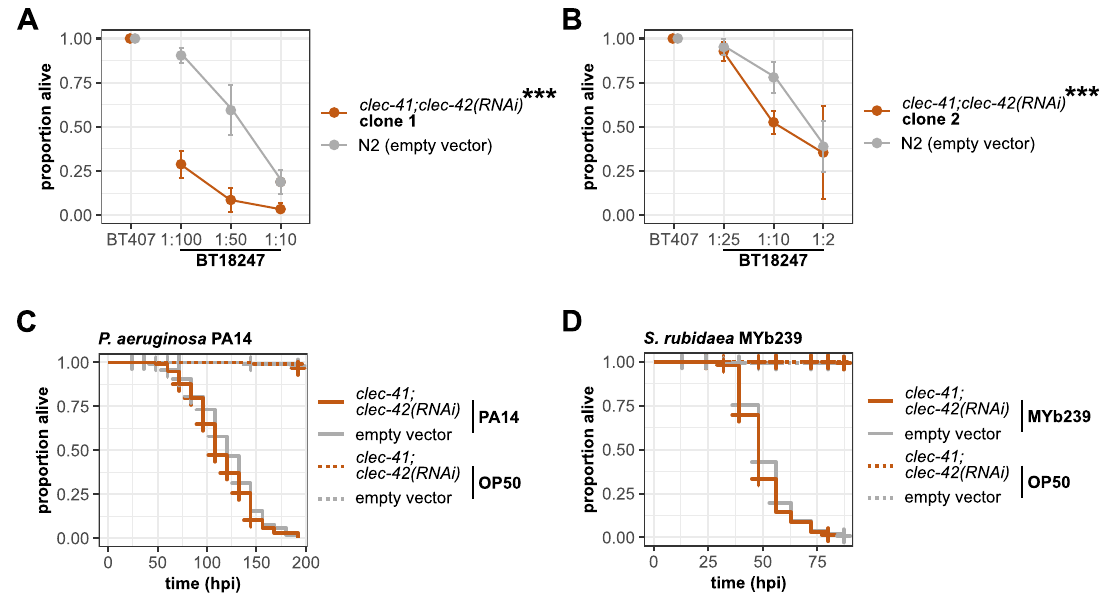
Fig 5. Simultaneous knock-down of clec-41 and clec-42 increases susceptibility to Bt247. (A, B) Difference in survival on serial dilutions of Bt247 and a dilution of 1:10 of the non-pathogenic Bt407 control 24 hpi between clec-41;clec-42(RNAi) worms and empty vector control worms using either (A) RNAi clone 1 (Ahringer library V-8P17) or (B) RNAi clone 2 (Ahringer library V-11P18). Means ± standard deviation (SD) of n = 5 are shown. Data are representative of five independent experiments. ��� p < 0.001, according to a generalized linear model (GLM) [57]. (C, D) Survival of clec-41;clec-42(RNAi clone 1 ) and RNAi empty vector control worms on (C) P . aeruginosa PA14 and (D) S . rubidaea MYb239 over time. Alive, dead, and missing worms were scored until all individuals on the pathogen were dead. No significant differences in survival between clec-41;clec-42(RNAi) and empty vector control worms as determined by Kaplan-Meier analysis [55] and log-rank test [56]. Horizontal ticks represent censored data (missing worms), n = 5. Also see S5A and S5B Fig, and S2D, S3I and S3J Tables.